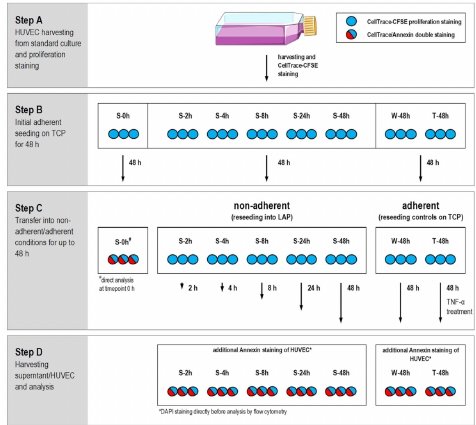
Figure 1. Design of the comparative study cultivating HUVEC in parallel under nonadherent and adherent conditions for up to 48 h is shown for one experimental repeat with three HUVEC seedings ( n = 3). The study was performed in the six well format with all together six HUVEC seedings for each sample in two independent experiments ( n = 6 in sum). Samples were S-2h till S-48h for sedimented HUVEC on low attachment plates (LAP) for periods up to 48 h in step C, whereby S-0h was analysed directly after step B. Periods in suspension are indicated by the time code of the sample description (S-2h, S-4h, S-8h, S-24h and S-48h). HUVEC controls W-48h and T-48h were grown on TCP for 48 h during step C, whereby T-48h samples were additionally treated with rhTNF- α to induce HUVEC inflammatory activation and apoptosis (Cell culture flask picture modified from Servier Medical Art; Licence: CC BY 3.0;